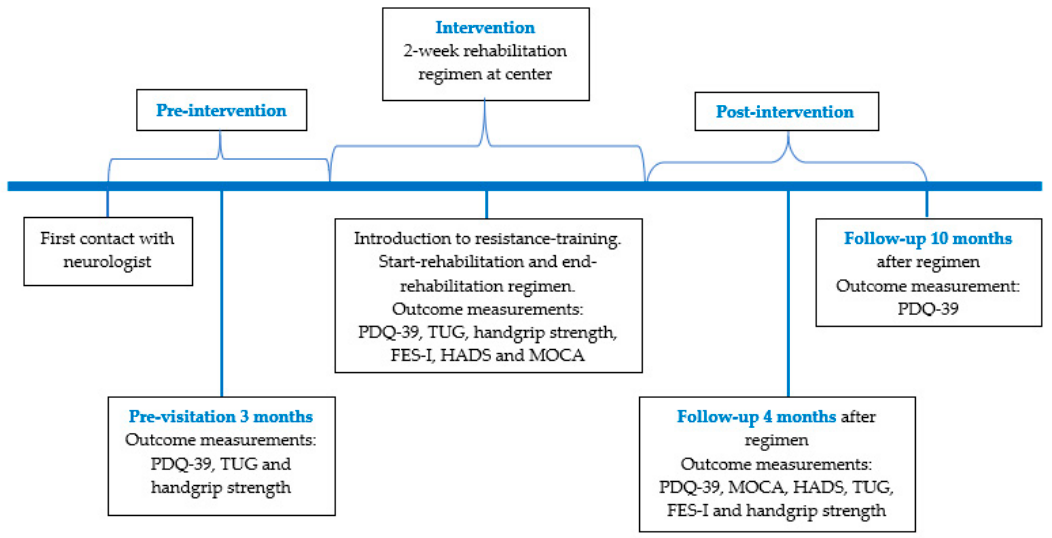
Figure 1. Diagram of the study. First contact: Neurologist. Pre-visitation: Outcome measurements performed at one of the two centers. Intervention period: 2 weeks rehabilitation regimen, a multidisciplinary approach. PDQ-39: Parkinson’s DiseaseQuestionnaire-39, TUG: Timed-up & Go, FES-I: falls-efficacy scale international, HADS: Hospital Anxiety and Depression Scale.